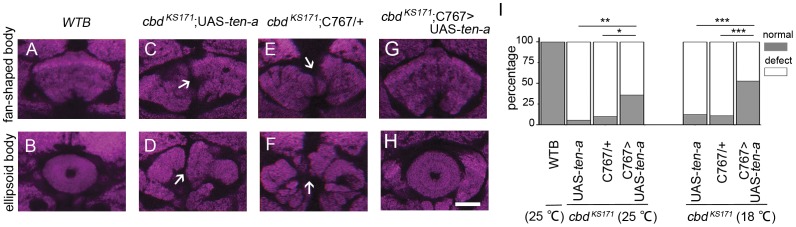
The cbd mutant phenotype could be significantly rescued when ten-a was driven by C767-Gal4.(A, B) WTB showed normal FB and EB. (C–F) Both UAS-ten-a and C767-Gal4 in the cbd KS171 background showed defect in FB and EB. (G, H) FB and EB were restored to normal when UAS-ten-a was driven by C767-Gal4. (I) Percentage of normal FB and EB in controls (5.6% for cbd KS171;UAS-ten-a, n = 36; 10% for cbd KS171;C767-Gal4/+, n = 30) and in flies with UAS-ten-a driven by C767-Gal4 (36%, n = 25). Two tailed Fisher exact test. *P<0.05, **P<0.01, ***P<0.001. When ten-a over-expressing flies were kept at 18°C, 47% (n = 32) of flies showed a normal FB and EB, much higher than control flies (12.5% for cbd KS171;UAS-ten-a, n = 24; 11.1% for cbd KS171;C767-Gal4/+, n = 18). Scale bar, 25 µm. Arrows indicate the central complex defect.